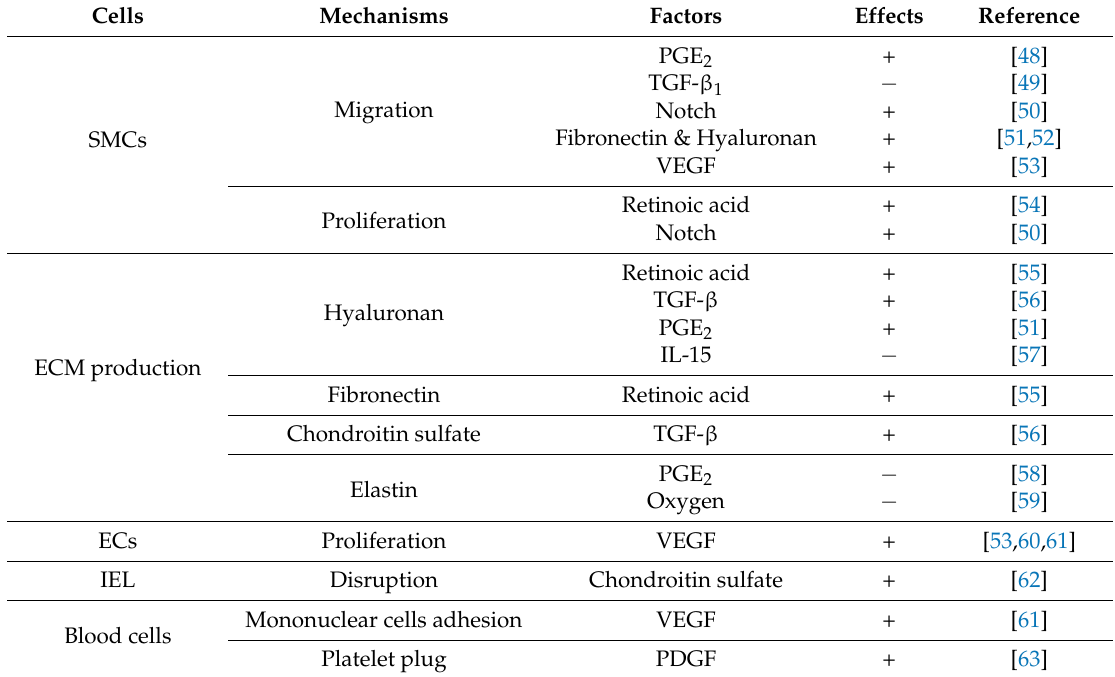
ECs: endothelial cells, ECM: extracellular matrix, IEL: internal elastic laminae, IL-15: Interleukin-15, PDGF: platelet-derived growth factor, PGE 2 : prostaglandin E 2 , SMCs: smooth muscle cells, TGF-β: transforming growth factor-β, VEGF: vascular endothelial growth factor.